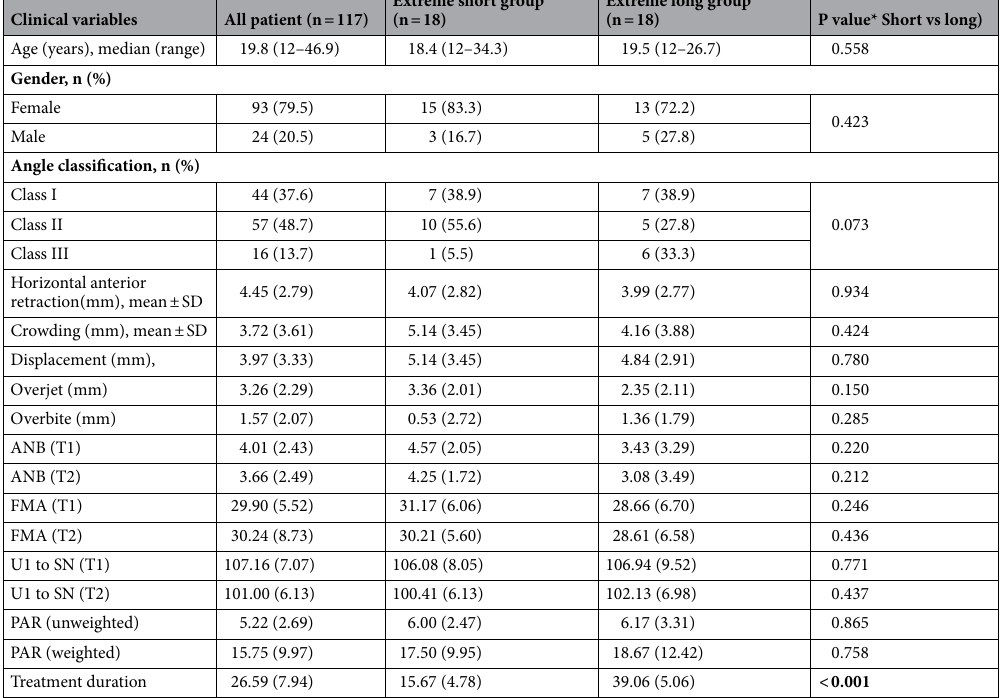
Table 2. The clinical characteristics of patients. Bold values denote statistical significance at the P < 0.05 level. *Chi-square test or t test were used where appropriate.